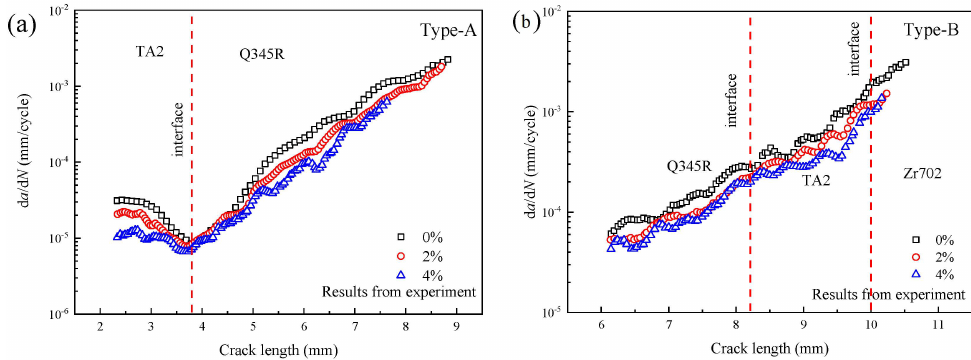
Figure 3. Effect of pre-strain on d a /d N : ( a ) Type-A crack, ( b ) Type-B crack.